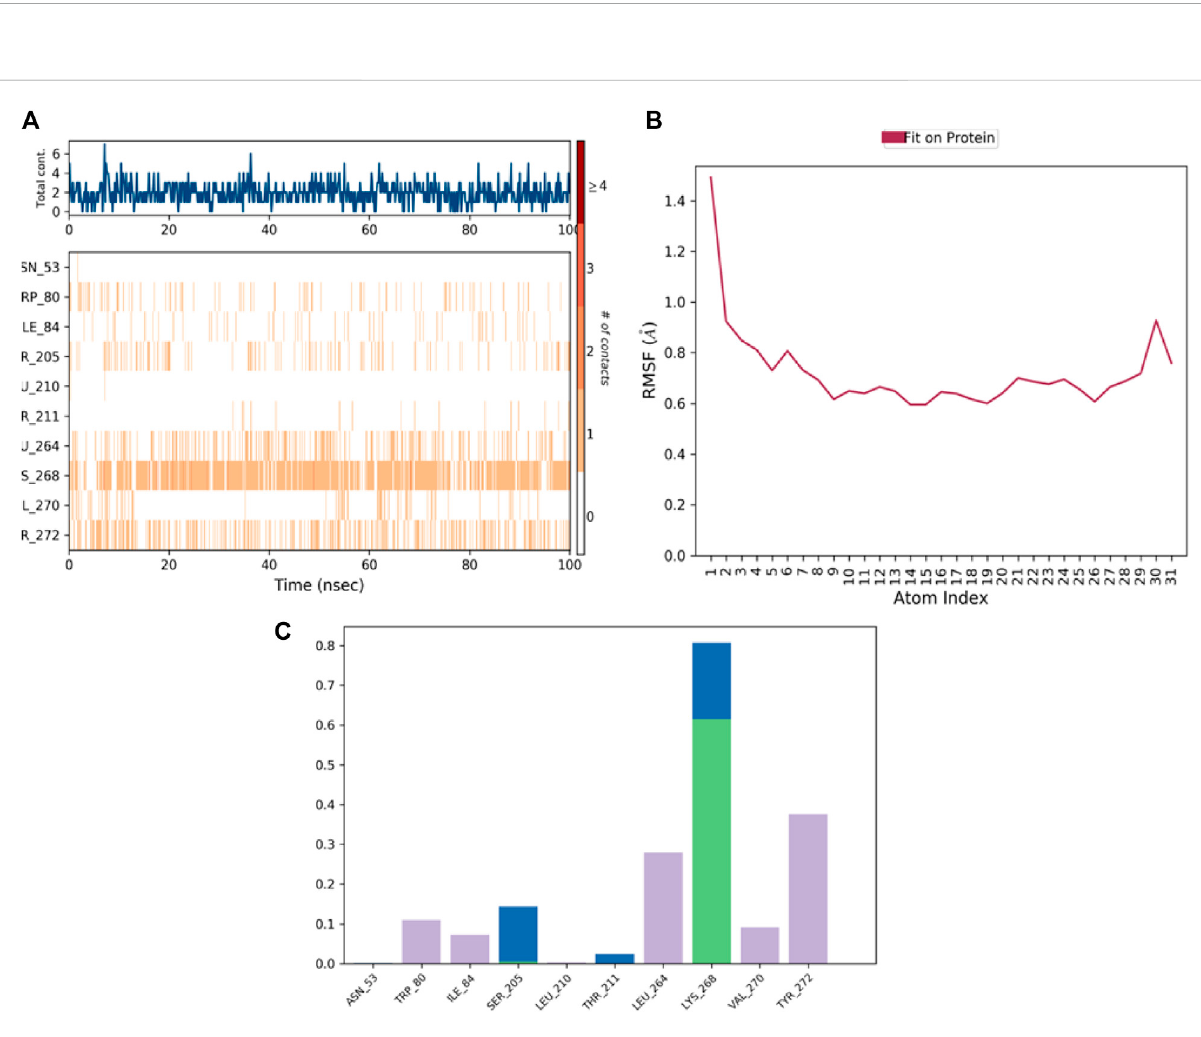
FIGURE 8 Aschematicofligand-ligand interactions. (A) Protein-ligandcontactscategorized byinteraction. (B) Timeline ofH-bond andhydrophobic contacts between protein and ligand. (C) Schematic diagram of ligand atom interactions with protein